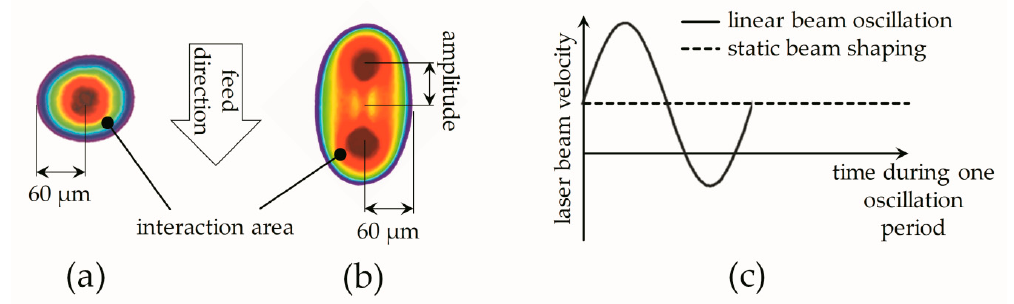
Figure 8. Beam diagnostic visualizes the interaction area and average intensity distribution of: ( a ) Static beam shaping; ( b ) Linear beam oscillation; ( c ) The laser beam velocity is constant for static beam shaping and alternates in case of longitudinal, linear beam oscillation.